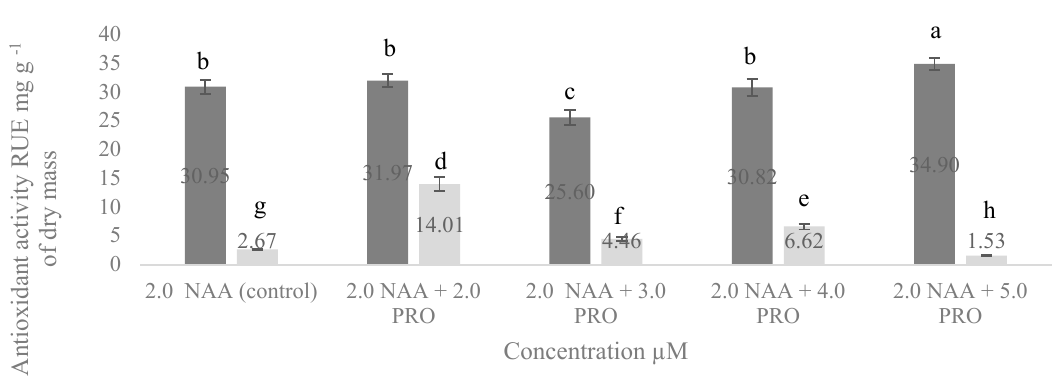
Figure 4. Effect of NAA and PRO concentration on antioxidant activity in cellular compounds of callus culture from stem and leaf explants. Means not sharing a common letter were significantly different ( p < 0.05). NAA, α –naphthalene acetic acid; PRO, proline.